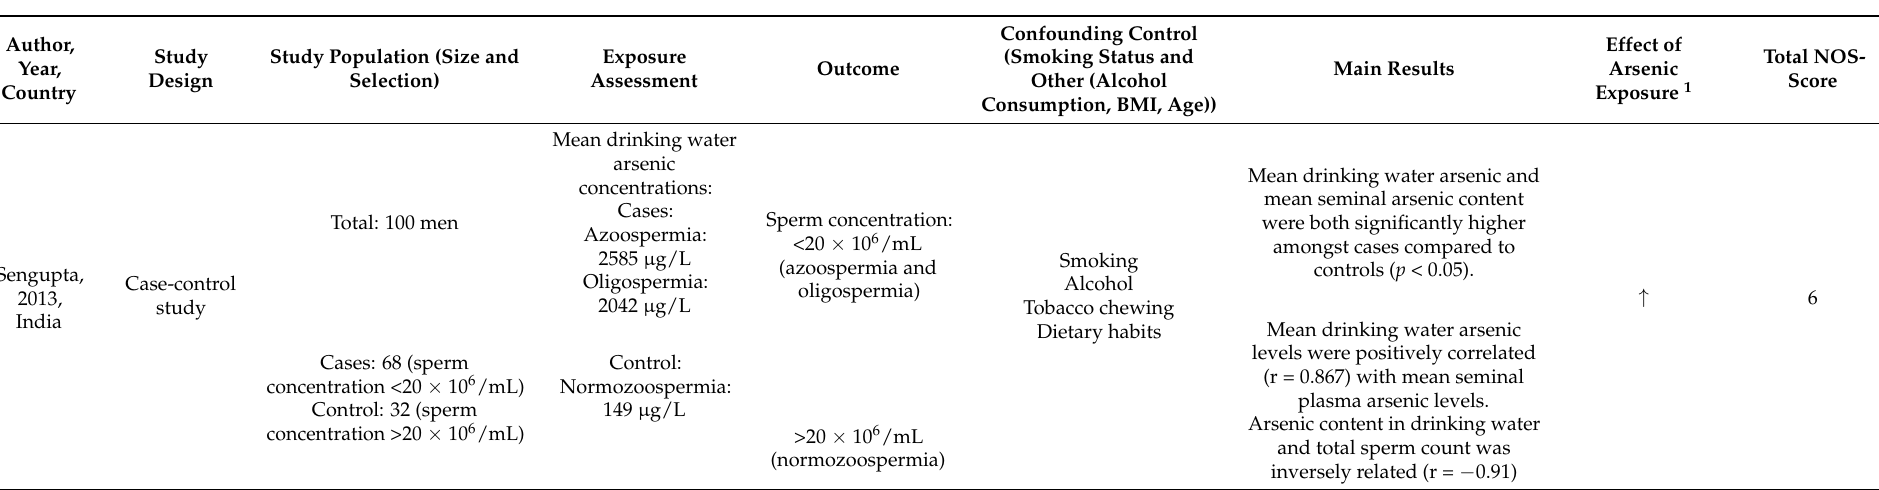
Table 2. Study Investigating Adverse Reproductive Outcomes in Men Included in the Systematic Review. Characteristics, Results and Assigned Newcastle-Ottawa Scale Score are Presented. Author,